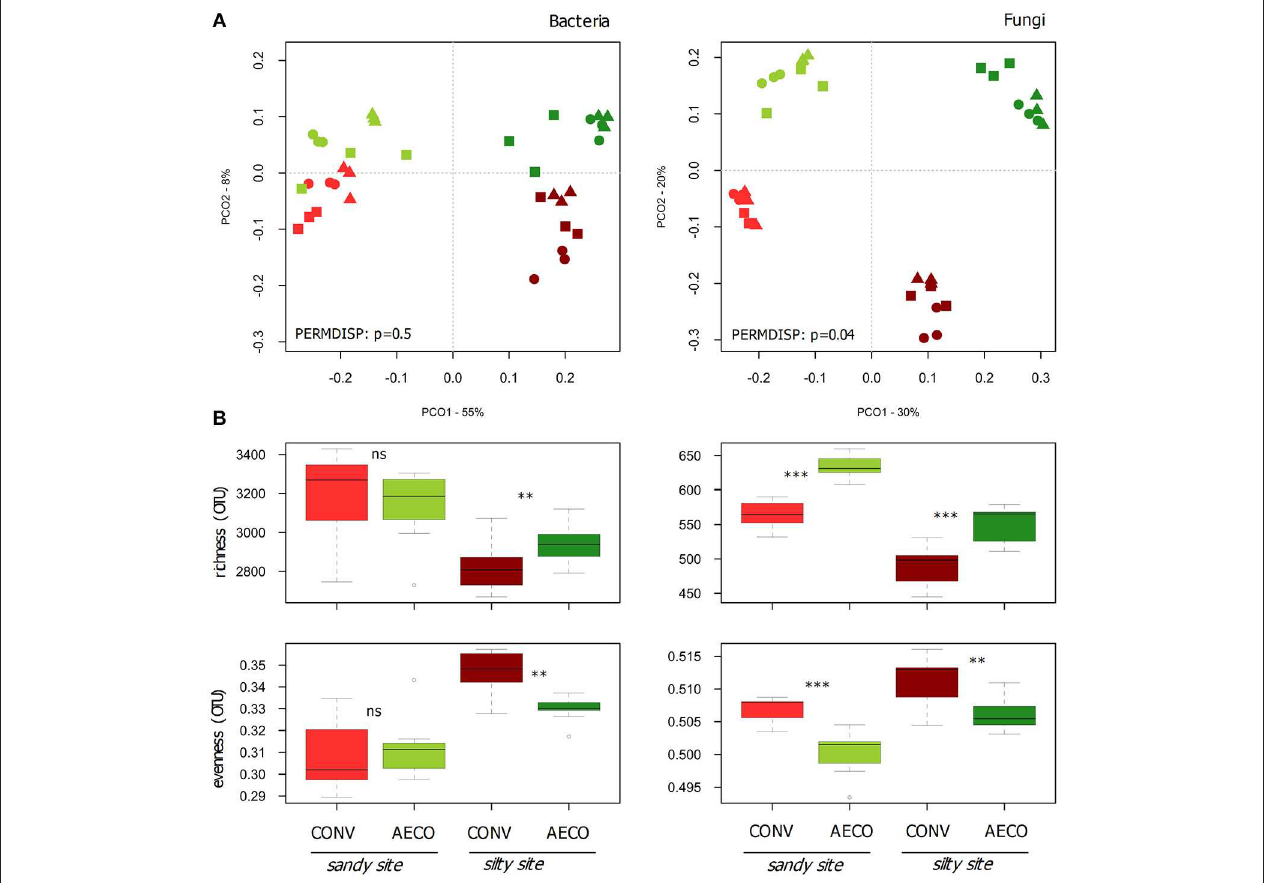
FIGURE 2 | Effects of site and agricultural management on bacterial and fungal β -diversity (A) and α -diversity (B) . (A) Principal coordinate analysis (PCO) based on Bray-Curtis similarities calculated from bacterial and fungal OTU abundance matrices. The variance explained by the axes (goodness of fit) is provided next to the axis headers. Agricultural management types are colored coded with red (conventional, CONV) and green (agroecological, AECO). Light colors represent the sandy site; dark colors represent the silty site. Statistical tests for assessing the heterogeneity of variance for the interaction effect between management and site as assessed by PERMDISP are provided in the ordinations. (B) Boxplots of observed richness and Smith-Wilson evenness calculated from the bacterial and fungal OTU matrices. The significant changes are labeled by asterisks: *** p < 0.001, ** p < 0.01, ◦ p < 0.1, and ns, non-significant. The p -values were corrected for multiple comparisons using the Benjamini-Hochberg